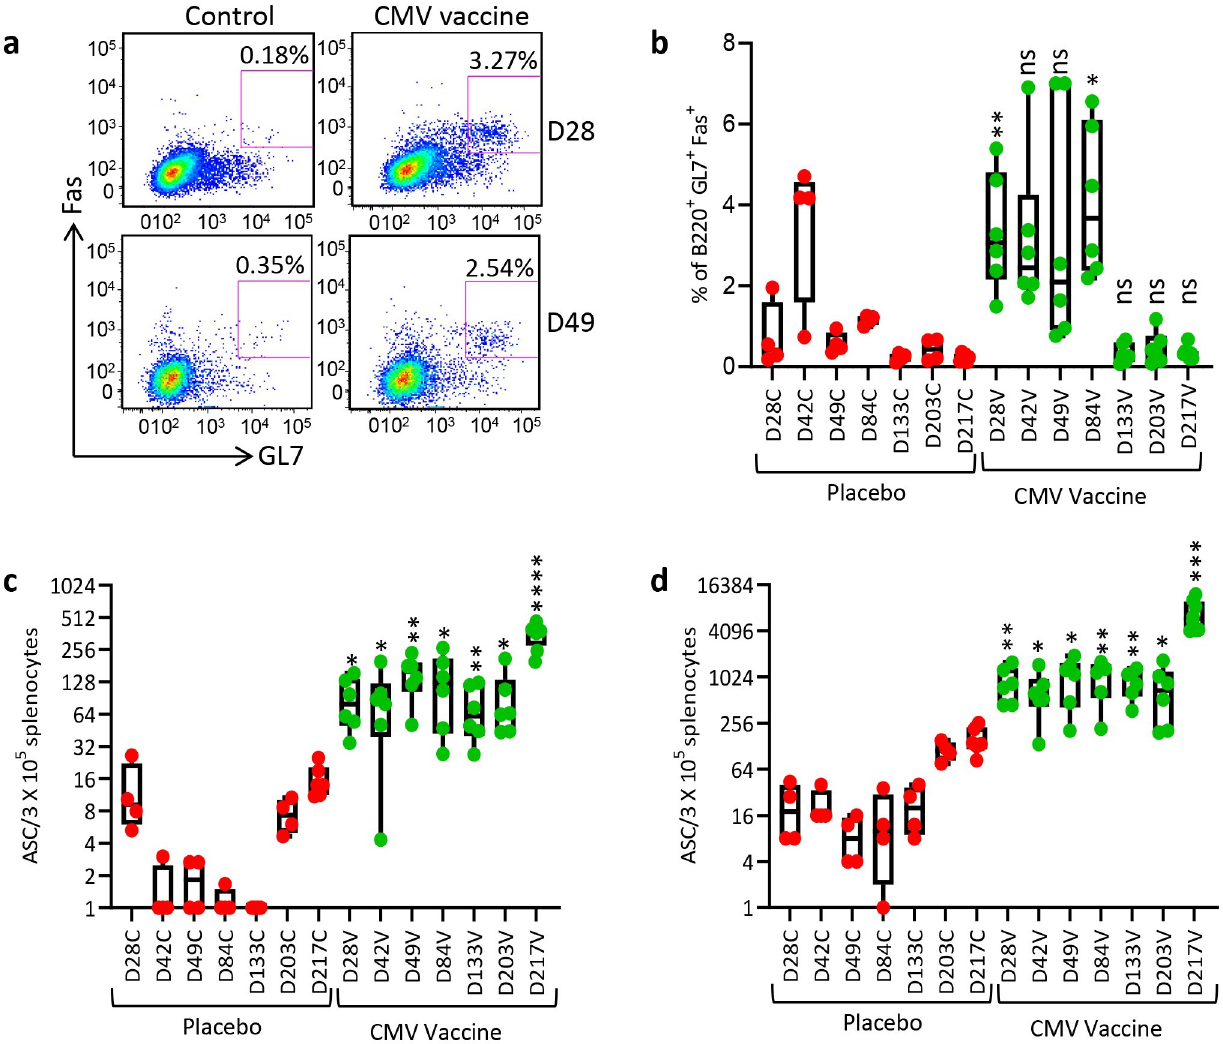
Fig 8. CMV vaccine induces long-term durable GC B cell and CMV gB-specific antibody secreting B cell responses: HLA A24 expressing mice immunized with CMV vaccine as outlined in Fig 6A and assessed for GC B cells and CMV gB-specific antibody secreting B cell responses. To determine the GC B cell responses, single cell suspensions were prepared from spleens and then stained with PE conjugated anti-B220, FITC conjugated anti-GL7 and APC conjugated anti-CD95 (Fas) antibodies. (a) Representative FACS plots of B220 + GL7 + Fas + B cells in spleens of mice immunised with CMV vaccine or placebo on day 28 and 49. (b) Frequencies of B220 + GL7 + Fas + B cells in spleens of mice immunised with CMV vaccine or placebo from day 28 to 217. (c and d) Ex vivo and memory antibody secreting B cells in splenocytes of mice immunised with CMV vaccine or placebo on days 28, 42, 49, 84, 133, 203 and 217 using ELISpot assay. � P < 0.05; �� P < 0.01; ��� P < 0.001, ���� P < 0.0001 by Welch’s t test. Statistics are indicated in comparison with control group. If statistics are not indicated, then the comparison was not significant